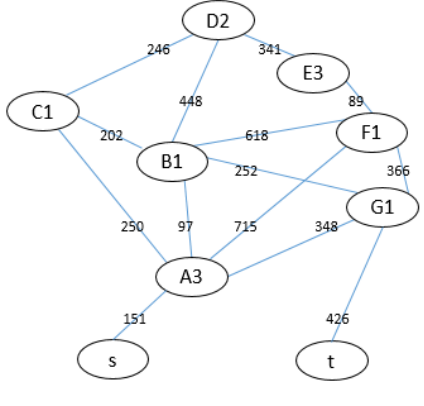
Fig. 4 （ a ） Traditional Scenic Spot Graph Model